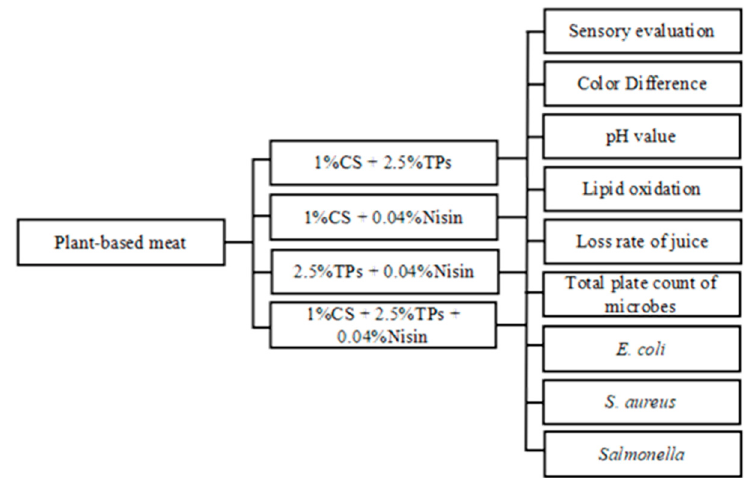
Figure 2. Experimental flow.